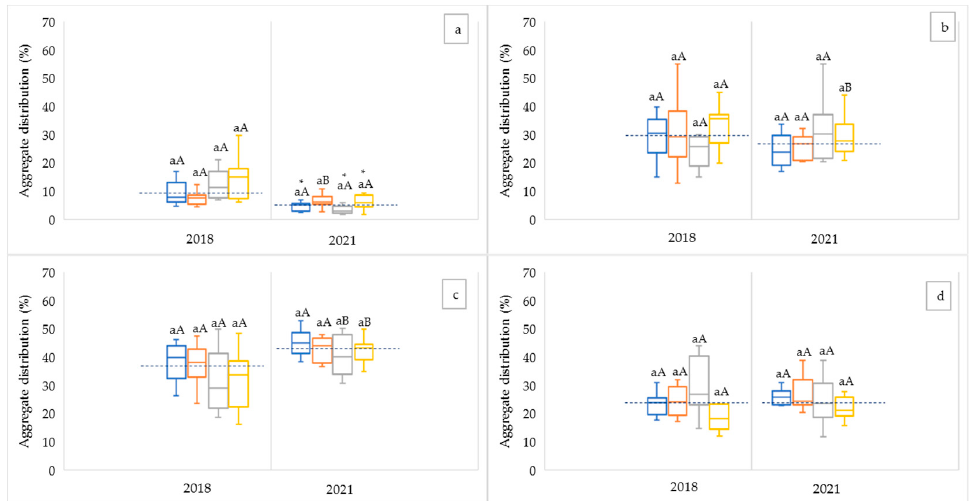
Figure 4. Soil water-stable aggregate size distribution (%) for conventional-tillage (CT; blue bars); saffron (D-S; orange bars); oats (D-O; grey bars), and lavender (D-L; yellow bars) treatments at 10–30 cm depth for ( a ) >2000 µ m, ( b ) 250–2000 µ m, ( c ) 53–250 µ m and ( d ) <53 µ m. The different lowercase letters above the error bars for the same soil layer indicate significant differences between managements at p < 0.05. Different capital letters are indicating differences in depth between 10–30 cm layer and 0–10 cm layer which is represented in Figure 3. Each cultivation system (*) represents significant differences with respect to the olive monocrop conventional tillage system in 2018 (con- trol treatment) by Dunnett’s test ( p < 0.01); missing asterisks denote non-significant differences. In depth significant differences were found in the D-S (>2000 μ m fraction) and D-L